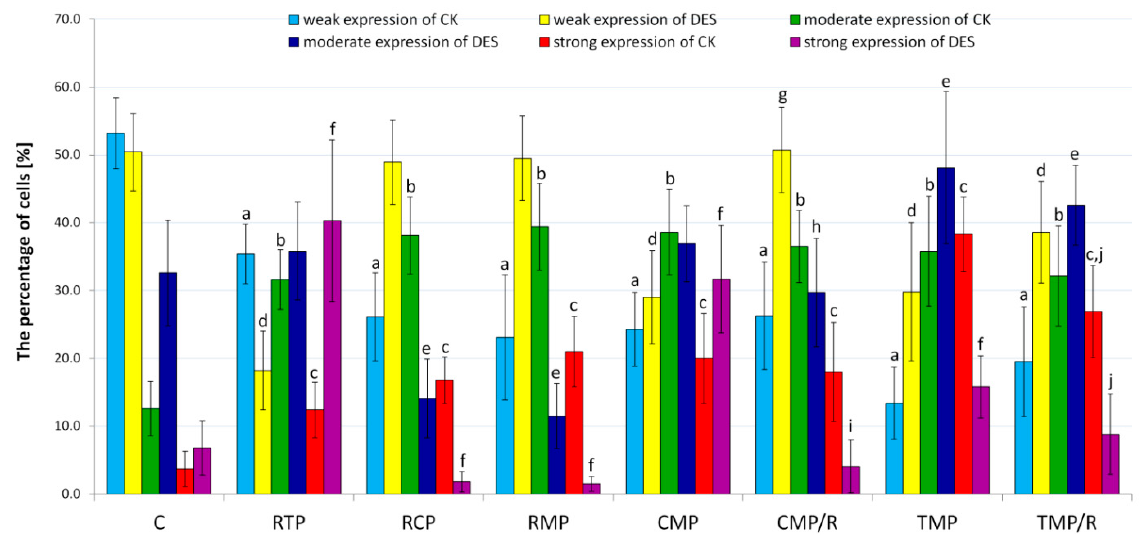
Figure 6. The percentage of cytokeratin- and desmin-positive cells in the rat ventral prostate. C: control group; CK: cytokeratin; CMP: rats treated with cyclosporin A, mycophenolate mofetil, and prednisone; CMP / R: rats treated with cyclosporin A, mycophenolate mofetil, and prednisone in the first three months and rapamycin in the last three months; DES: desmin; RCP: rats treated with rapamycin, cyclosporin A, and prednisone; RMP: rats treated with rapamycin, mycophenolate mofetil, and prednisone; RTP: rats treated with rapamycin, tacrolimus, and prednisone; TMP: rats treated with tacrolimus, mycophenolate mofetil, and prednisone; TMP / R: rats treated with tacrolimus, mycophenolate mofetil, and prednisone in the first three months and rapamycin in the last three months; p < 0.001 vs. control for weak (a), moderate (b), and strong (c) expression of cytokeratin; p < 0.001 vs. control for weak (d), moderate (e), and strong (f) expression of desmin; p < 0.05 vs. CMP for weak (g), moderate (h), and strong (i) expression; p < 0.05 vs. TMP for strong (j) expression (Kruskal–Wallis test, n = 30 for each grade of expression in each group); error bars represent standard deviations.